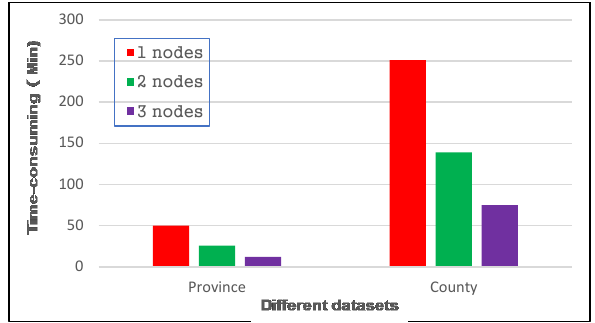
Figure 14. The time-consuming comparison of the tile pyramid construction in a cluster environment.